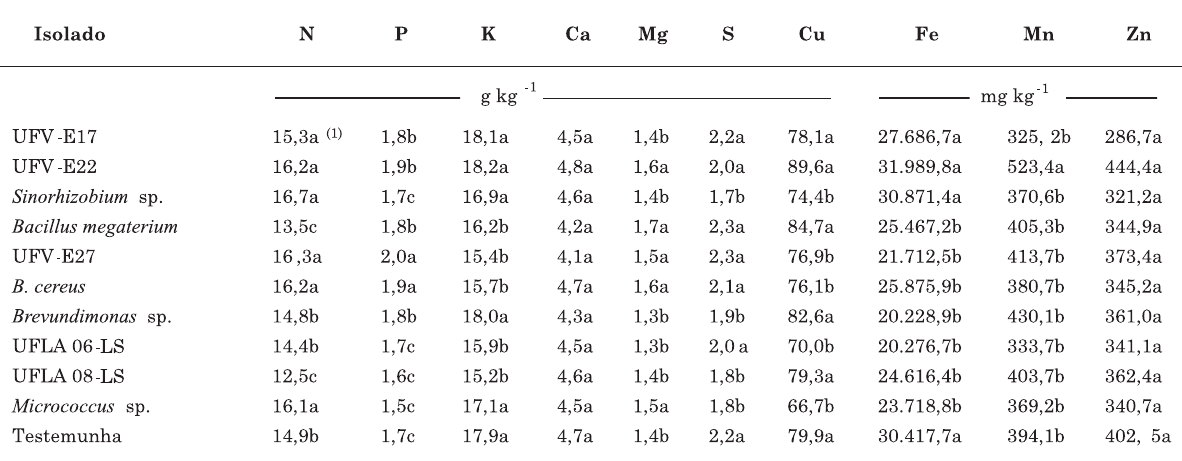
Quadro 2. Teores de nutrientes das raízes de plantas de tomateiro inoculadas com bactérias endofíticas e testemunha sem